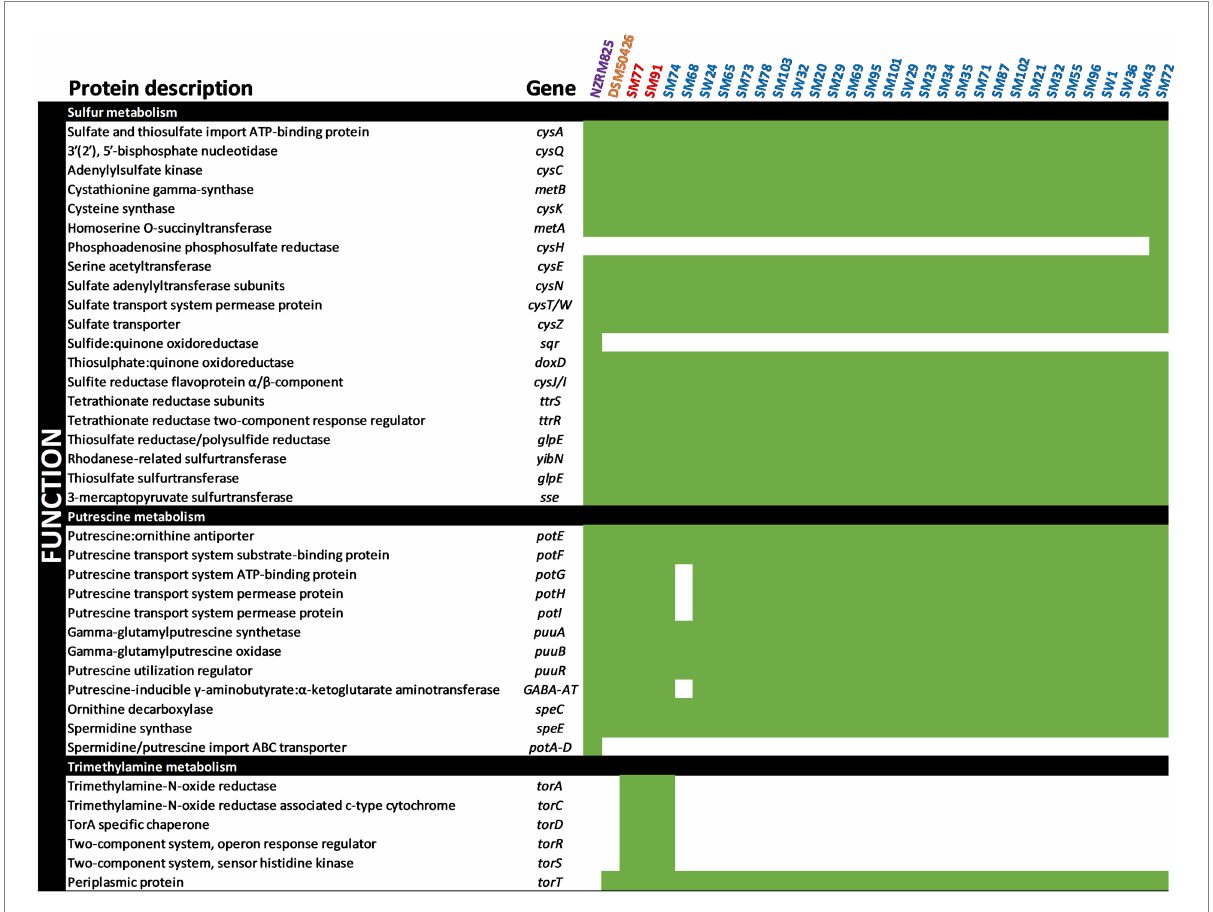
FIGURE 2 Occurrence of spoilage-related genes in Shewanella genomes. Presence (green) or absence (white) for each gene is